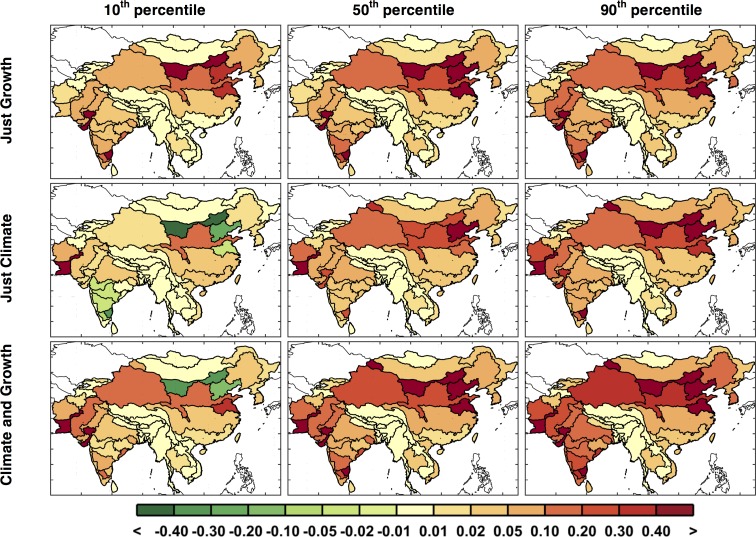
Exceedance changes in decadal averaged WSI (unitless).Changes are based on the baseline (Fig 7) to the future scenarios averaged over 2041–2050 and shown for the 10th, 50th, and 90th percentiles for each ASR.